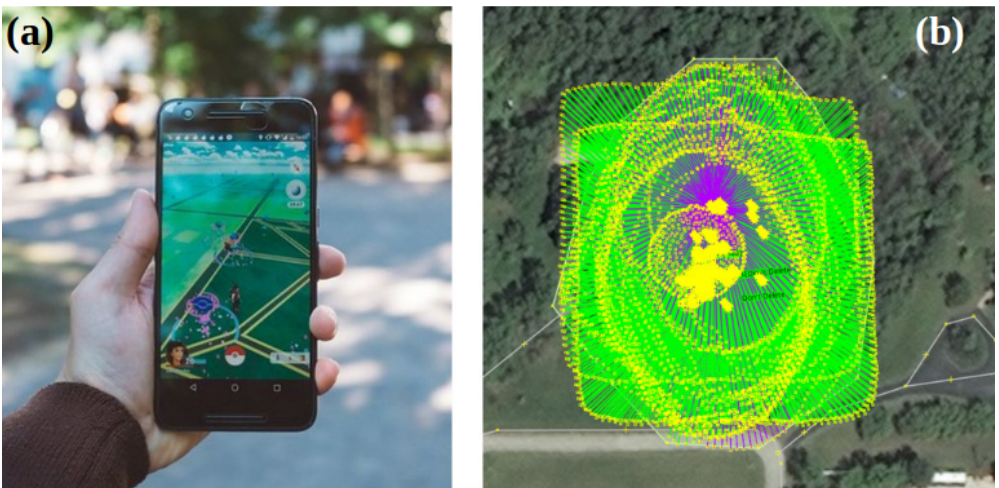
Figure 1. ( a ) Smartphone running Pokémon Go (PGO) with its map interface and ( b ) a PGO user adding fake footpaths to OpenStreetMap (OSM) in a park. Image credits: ( a ) https://paintimpact.com/ CC-BY, ( b )